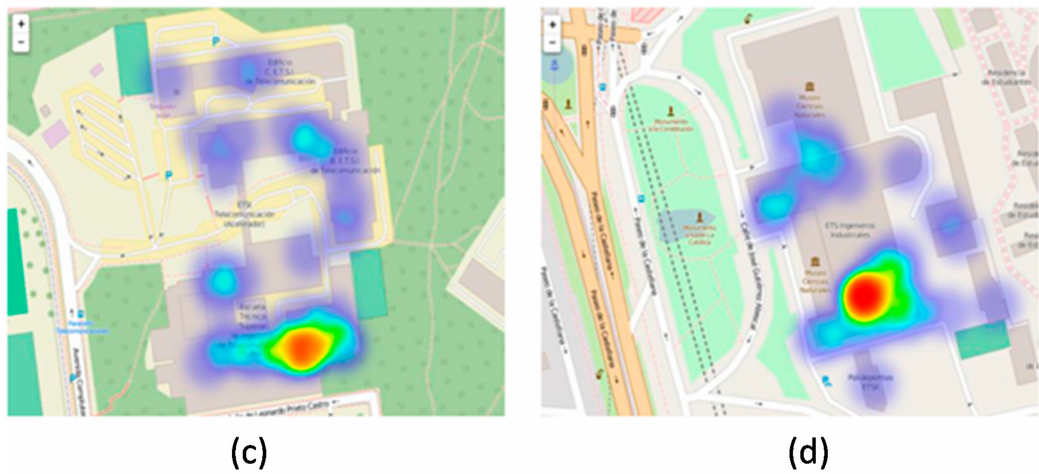
Figure 13. ( a , b ) Distribution of the people flow monitoring sensors at the Telecommunications Engineering School and at the Industrial Engineering School respectively; ( c , d ) Snapshot of the occupation in the different premises of the Telecommunications Engineering School and the Industrial Engineering School respectively.